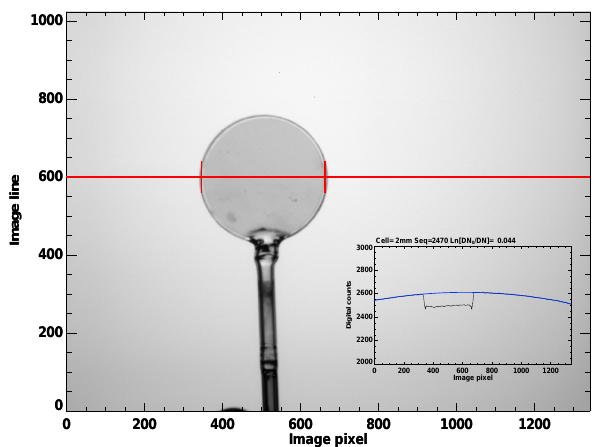
Fig. 6. Camera calibration using a bespoke SO 2 cell. The inset plot shows the intensity variation along the red line that cuts through a central part of the cell. The image counts (digital counts or digital numbers) is reduced as the light is attenuated by the SO 2 in the cell. The blue line is the Gaussian-cubic fit to the counts. The rapid variations near at the start and end of the intensity drop are due to the edges of the quartz cell and are removed before processing. The amount of SO 2 gas in this cell is ∼